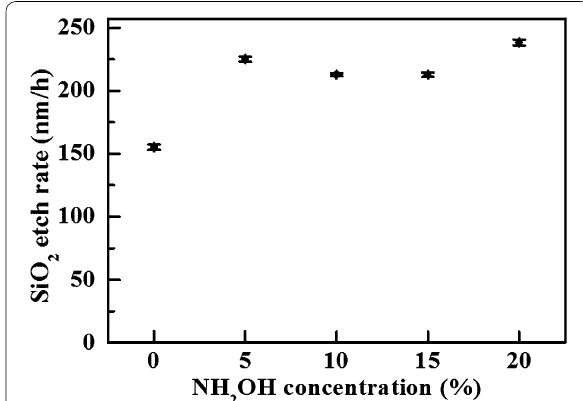
Fig. 1 Etch rate of Si{110} in pure and various concentrations of NH 2 OH-added 20 wt% KOH solution at 75 °C